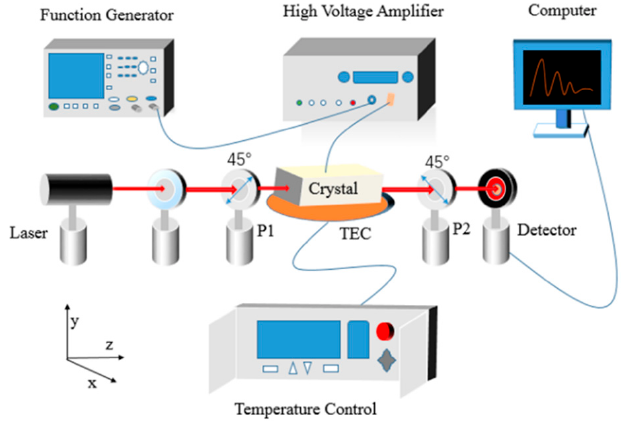
Figure 4. Schematic representation of the experimental optical path.